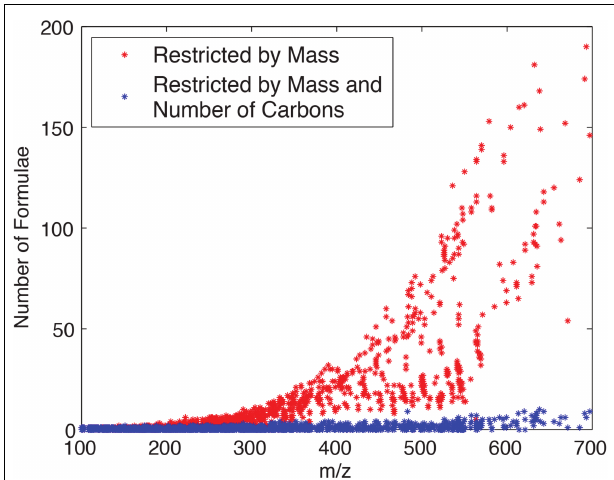
FIGURE 2 | Number of possible molecular formulae as a function of mass restricted by mass alone (red) or both mass and number of carbons (blue). When restrained by both mass and number of carbons, the number of possible molecular formulae for a given mass is severely restricted. Figure adapted with permission from Stupp et al.